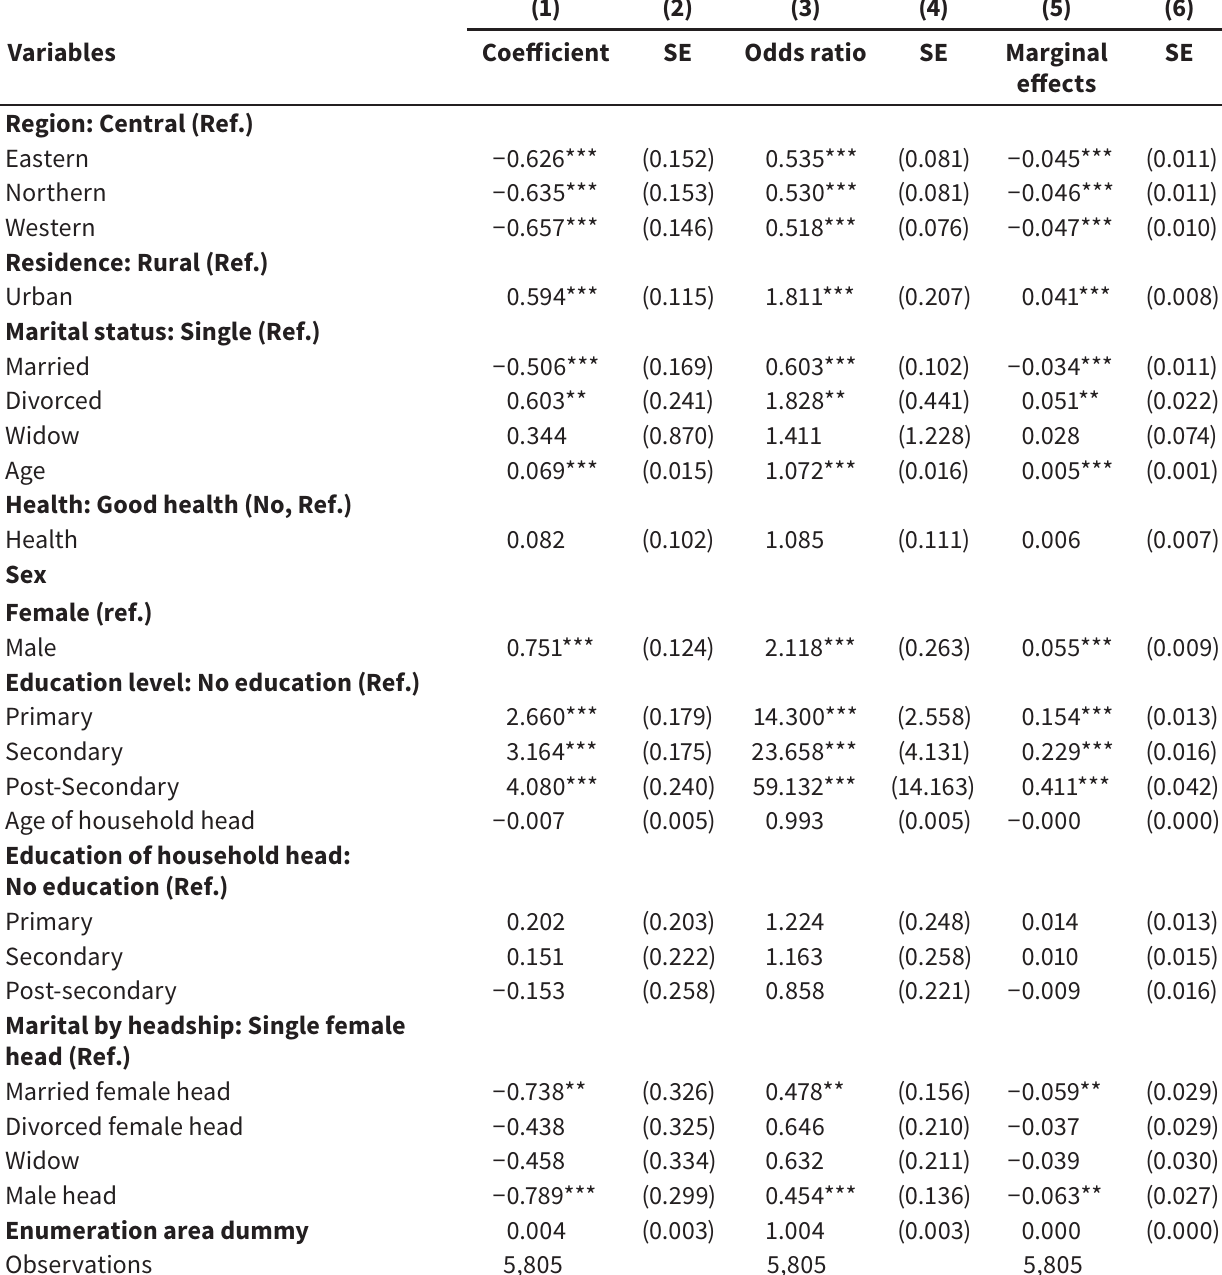
Determinants of youth unemployment – logistic regression